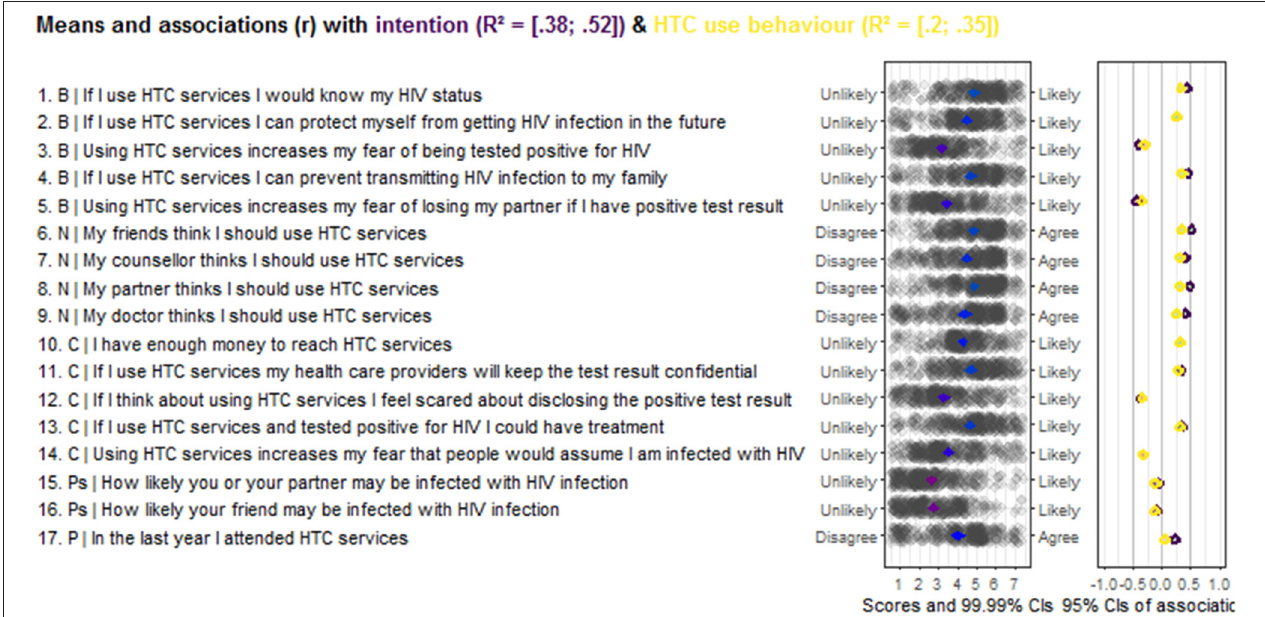
FIGURE 1 | Output CIBER regarding Social-Cognitive beliefs of the intention and use of HTC services behaviour among TB in Kassala State, Sudan ( N = 441). Behavioural beliefs; N, Normative beliefs; C, Control beliefs; Ps, Perceived Susceptibility; P, Past behaviour.